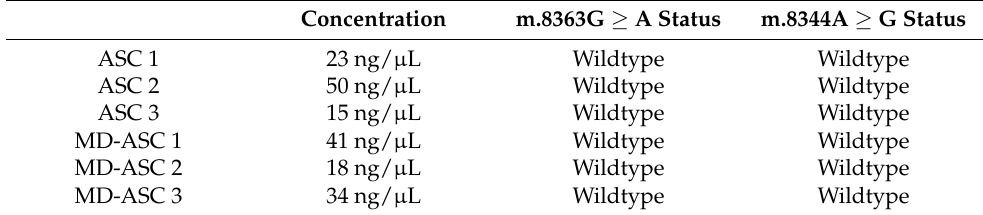
Table 3. Mitochondrial DNA concentration and mutational